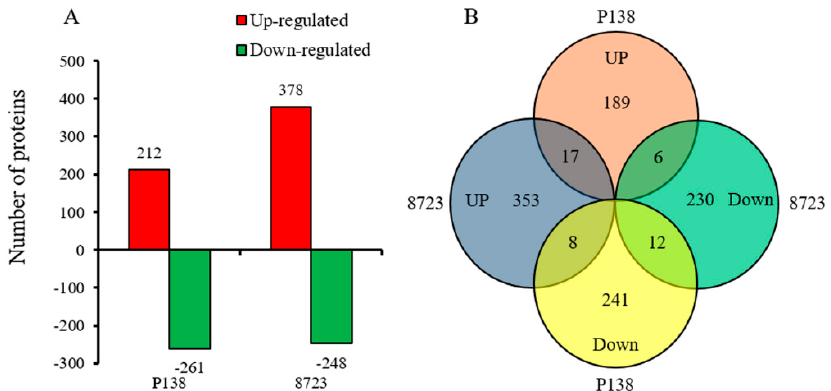
Figure 3. Comparative analysis of di ff erentially expressed proteins in two maize varieties. ( A ) Number of up-regulated and down-regulated di ff erentially expressed proteins (DEPs). ( B ) Venn diagram of root DEPs in two maize varieties.